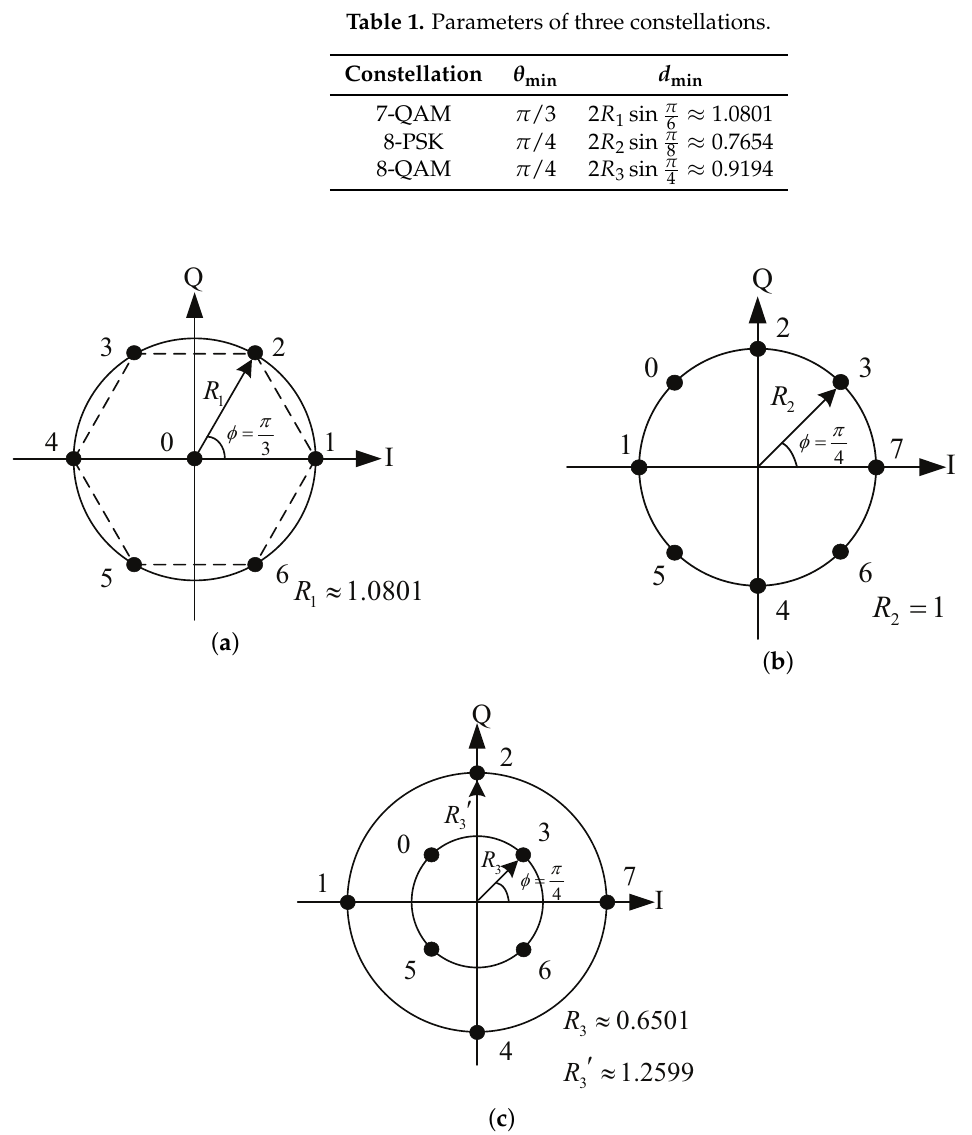
Figure 2. Constellation diagrams. ( a ) 7-QAM; ( b ) 8-PSK; ( c )